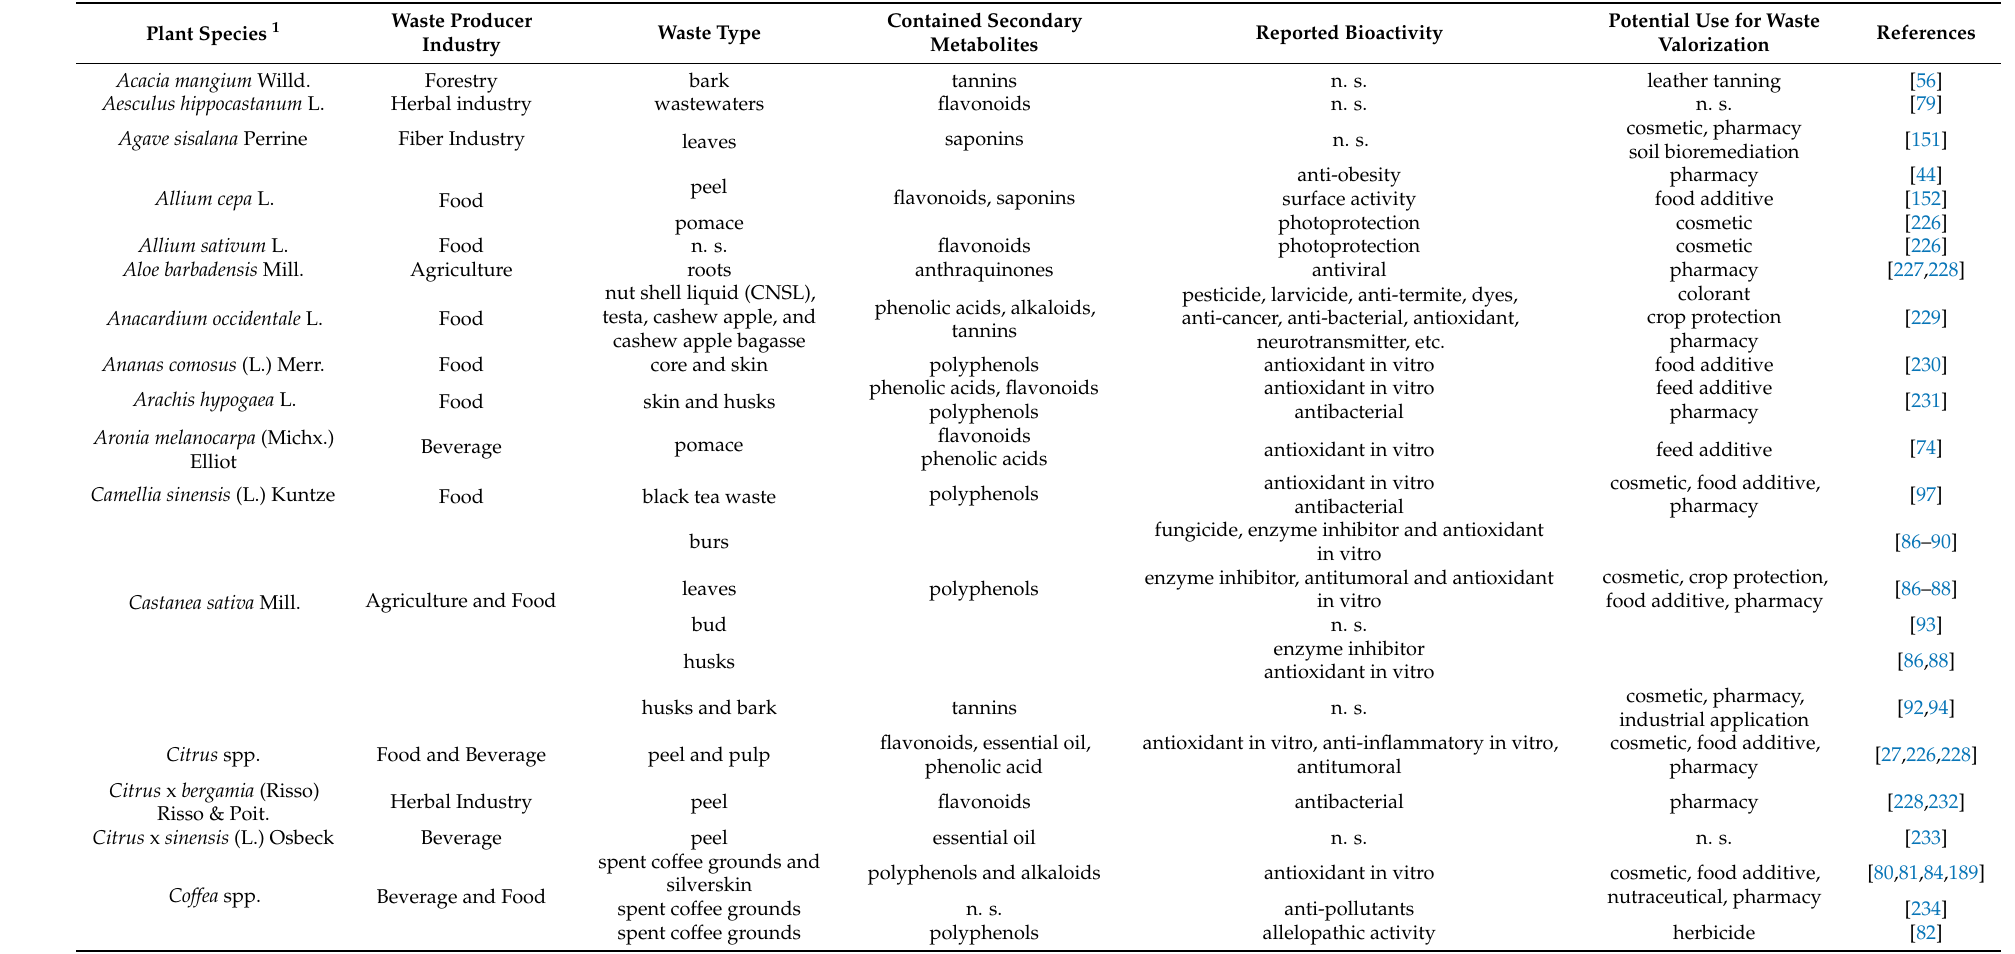
Table 1. Summary of the results emerging from the survey. The table reports: plant species from which the waste is generated, the industrial sector manufacturing the plant material, the nature of the produced waste, the class of secondary metabolites found in the waste material, the bioactivity possessed by waste extract(s), the potential use for waste valorization, and the corresponding reference source of all the information reported in a line. If no biological activity was investigated, or no potential valorization in a specific field was proposed, the wording “not specified” (n. s.) was inserted in the corresponding